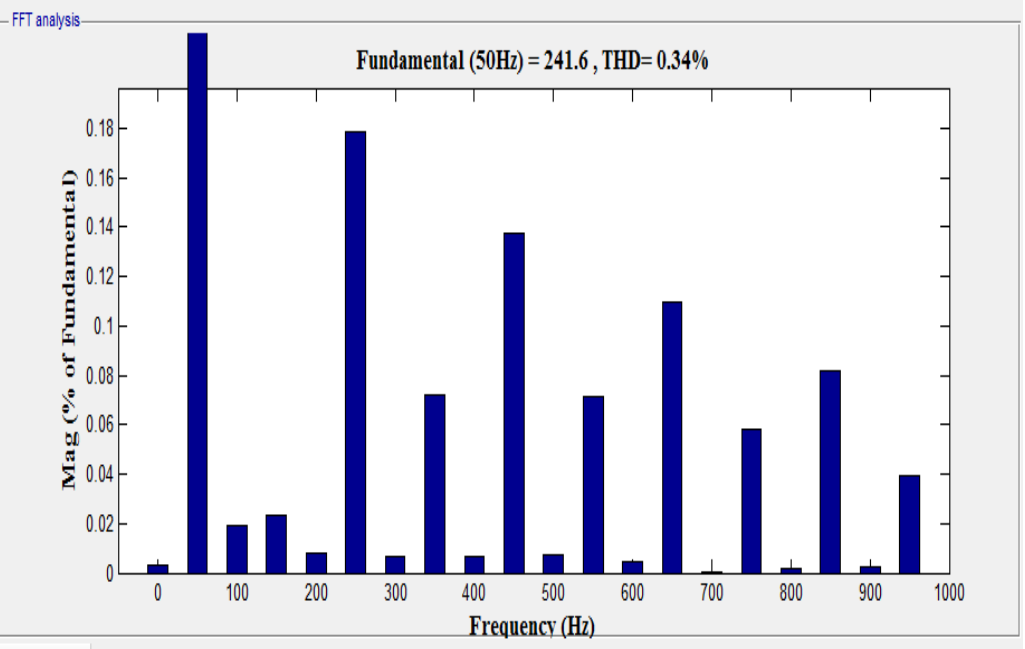
Figure 14. Frequency spectrum for resistive load.